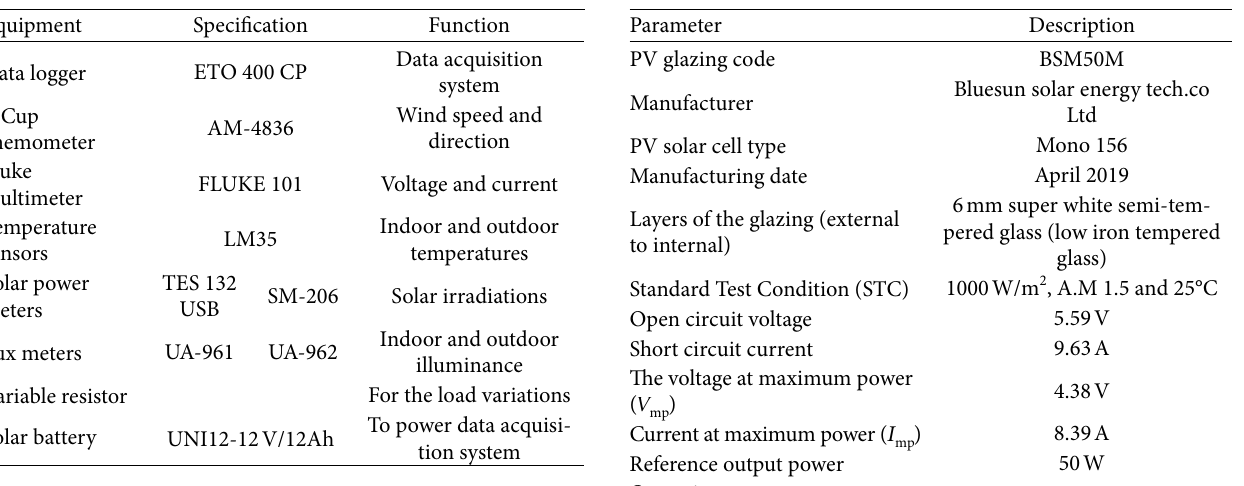
Table 2: Descriptions of the PV